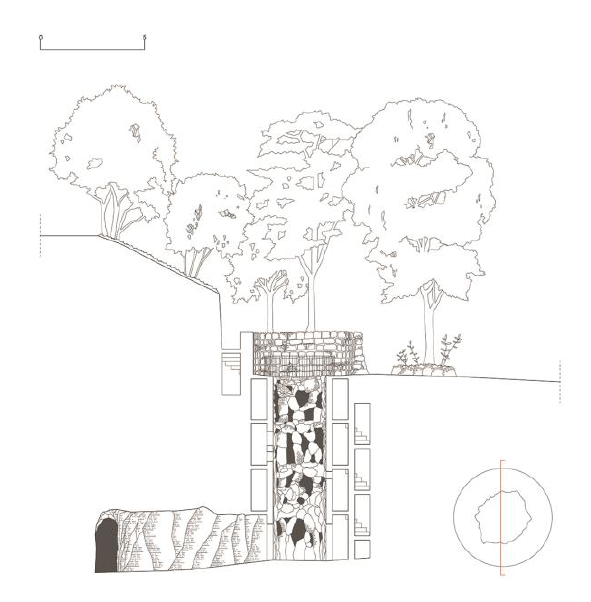
Figure 9 . The Quinta da Regaleira in Sintra, the Poço Imperfeito , cross section.